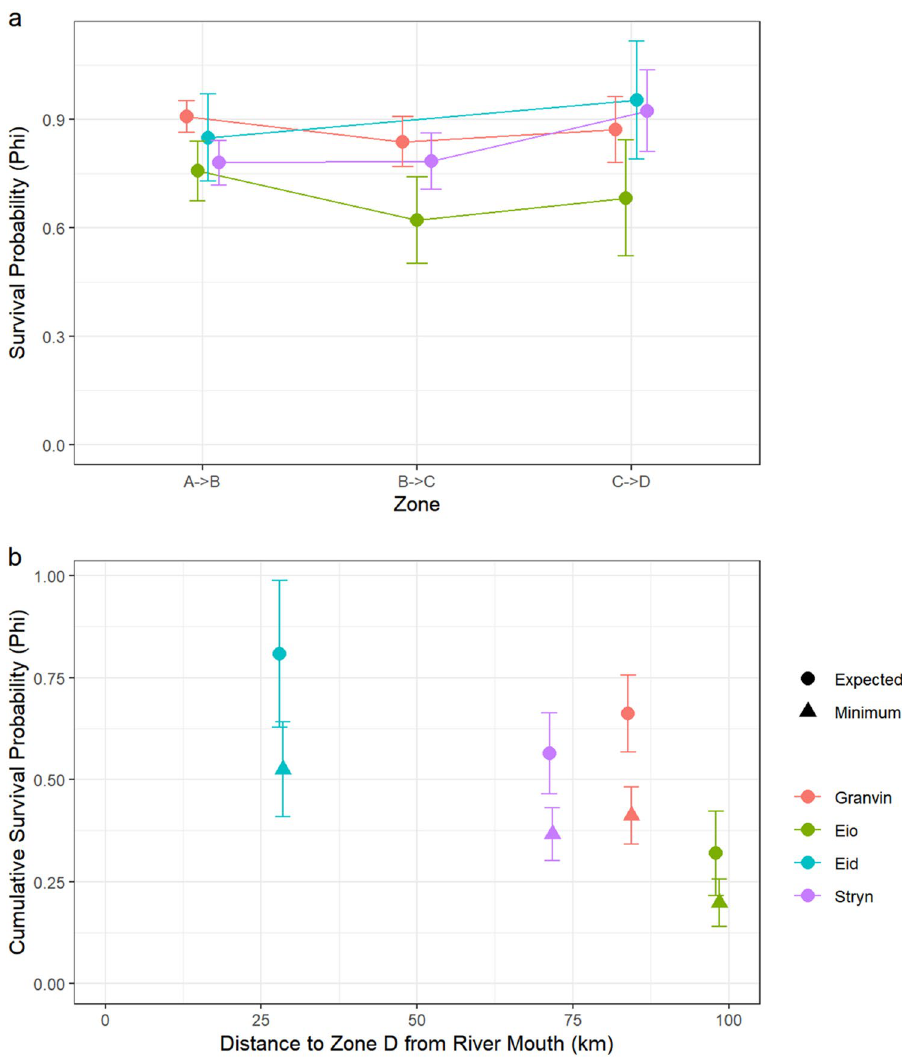
Figure 7. ( a ) Estimated probability of survival between each zone of the fjord for all rivers. Error bars represent standard error of estimates. Survival probabilities in the last transition are expected survival probabilities based on a best guess of the probability of detection equal to 0.65. ( b ) Minimum and expected cumulative survival probabilities for the entire fjord migration for each river as a function of the distance from the river mouth to the last zone. Error bars represent standard error of